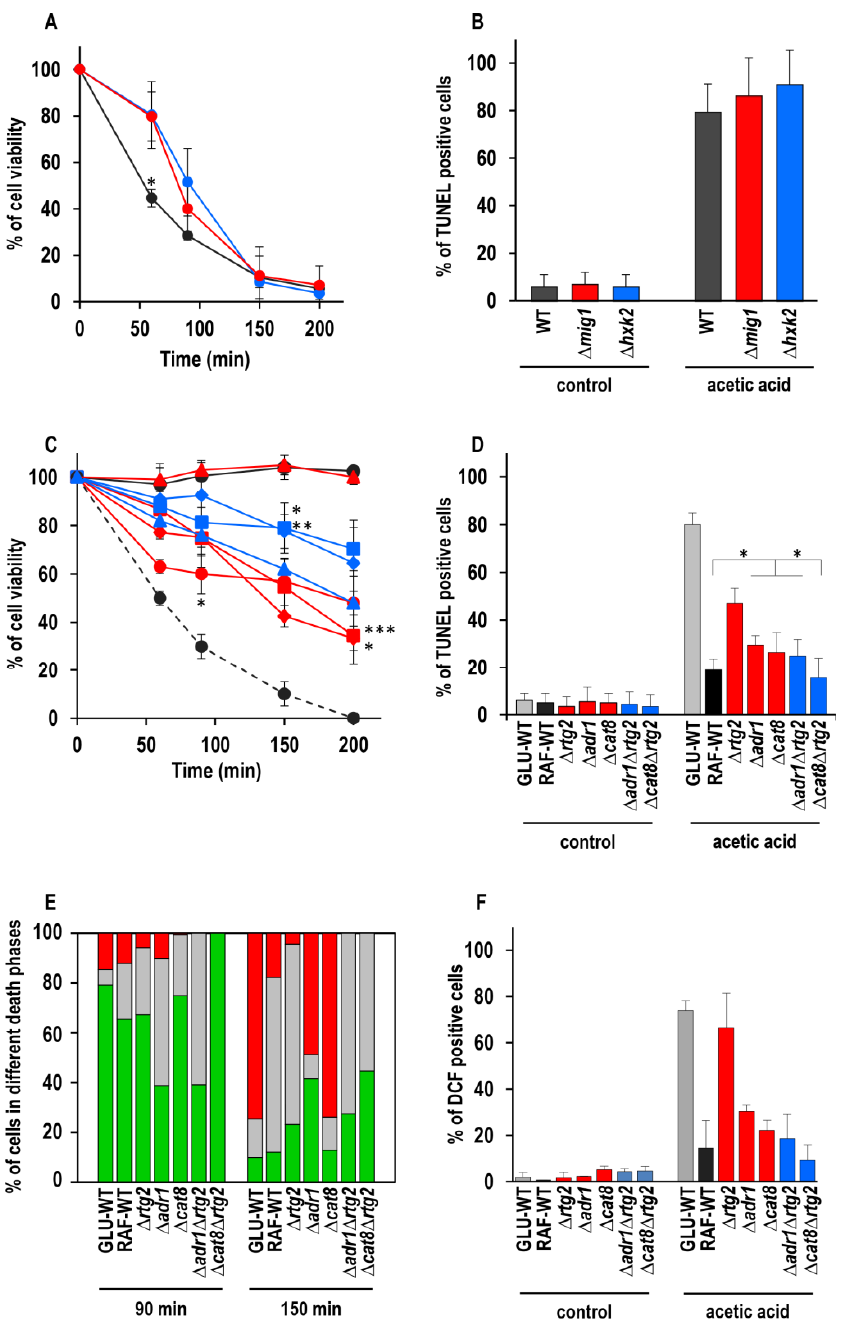
FIGURE 2: Effect of genetic inactiva- tion of both RTG and CCR pathways on AA-PCD in either glucose- or raffi- nose-grown cells. (A) Wild-type (WT, black), Δ mig1 (red) and Δ hxk2 (blue) mutant cells were treated with 80 mM acetic acid in growth medium with glucose as carbon source. Cell viability was analyzed by measuring colony- forming units (cfu) at indicated